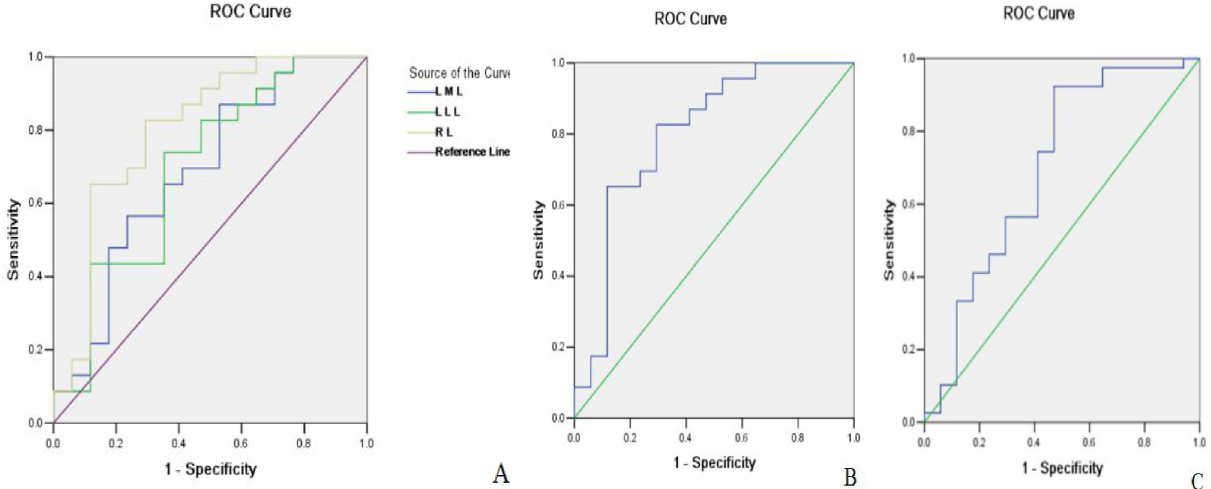
Fig 2. Receiver operating characteristic curves of liver lobe based T2 * values to identify the presence and Child-Pugh class of cirrhosis in patients with hepatitis B. The figures show that T 2 * value of left medial liver lobe (LML), left lateral liver lobe (LLL), and right liver lobe (RL) are indicators for the discrimination between cirrhosis patients and healthy participants (A), and between Class C and healthy participants (B), and between Child-Pugh class A-B and C of cirrhosis (C).